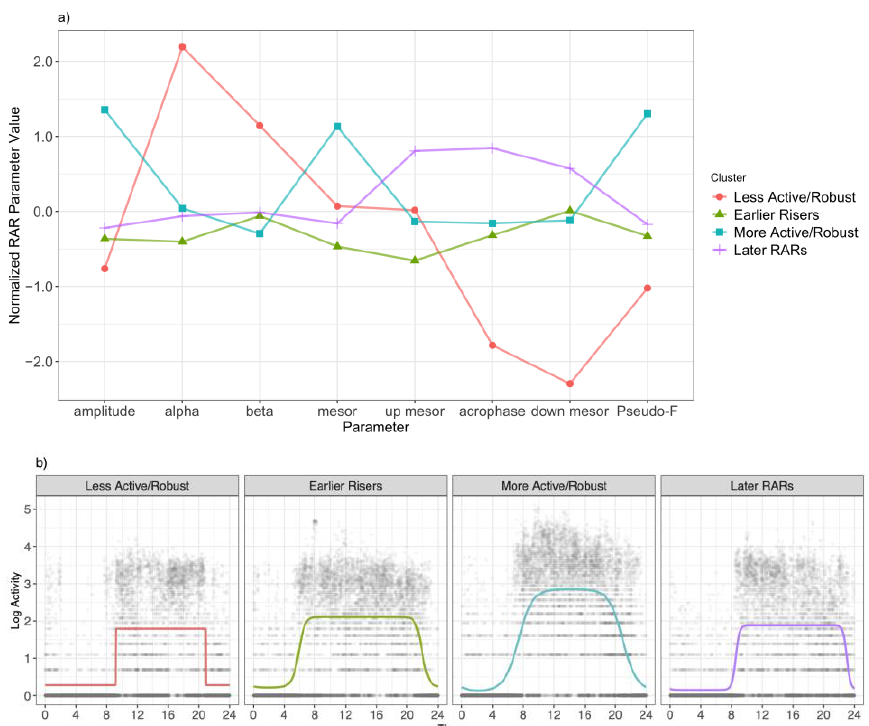
Figure 3. Rest–activity rhythm (RAR) profiles defined by the k-means cluster analysis. ( a ) Each k-means derived cluster’s mean RAR parameter estimates from the antilogistic extended cosine model. ( b ) Example estimated RAR patterns highlighting key differences between each RAR cluster type. Solid lines indicate the predicted RAR based on the extended cosine model; dots represent individual log activity count observations over the study period.